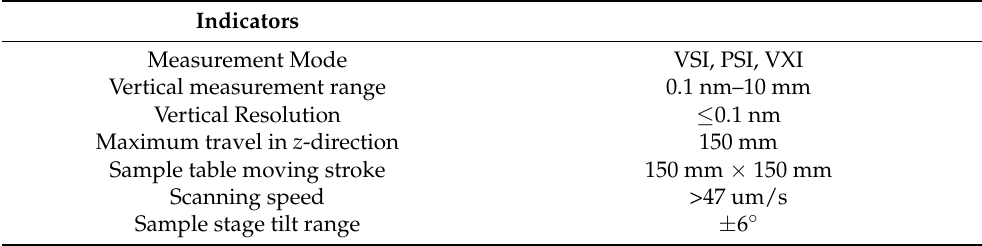
Figure 4. Machined rough surface. ( a ) 3D topography measuring instrument. ( b ) The ground surface. Table 3. UP-Dule Mode performance indicators.